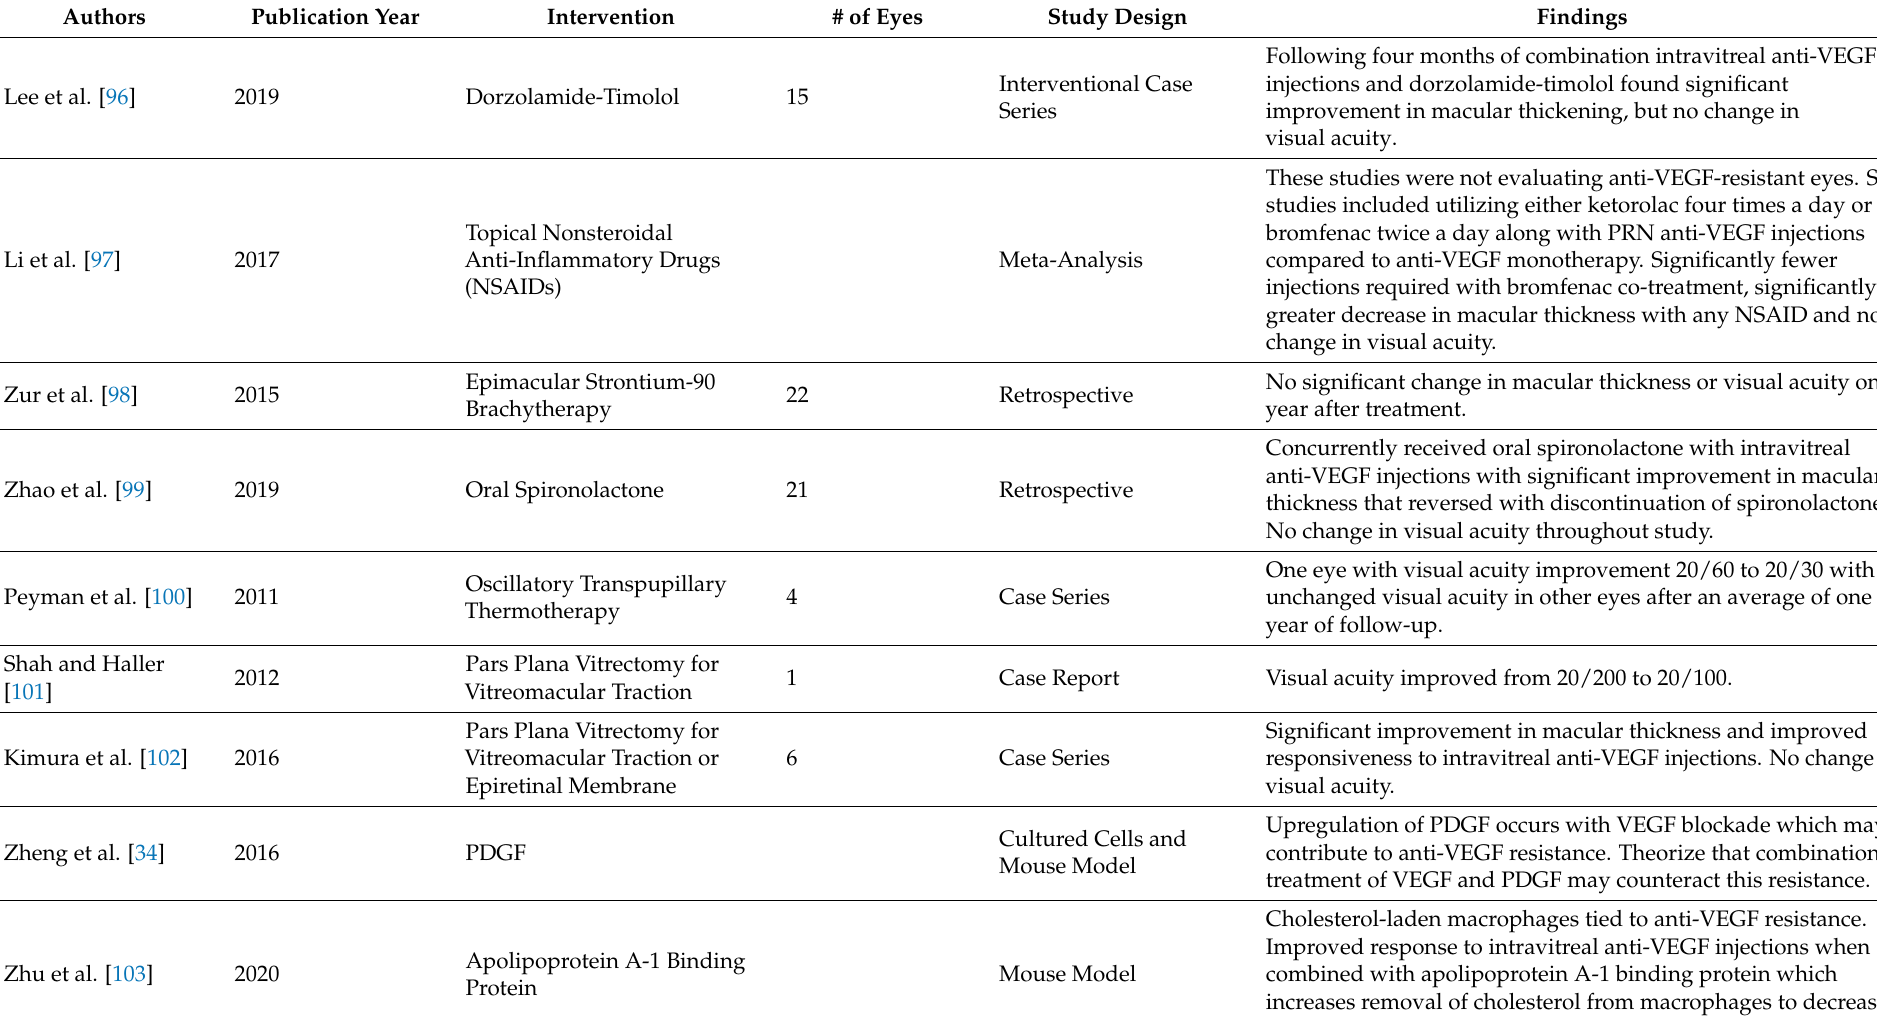
Table 1. Miscellaneous Treatments of Anti-VEGF-Resistant Exudative Macular